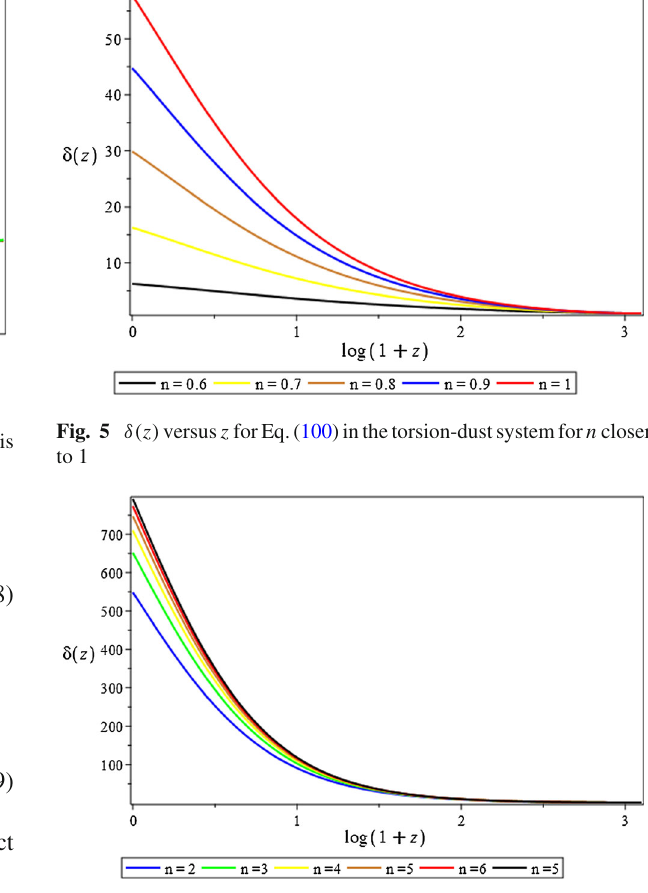
Fig. 6 δ( z ) versus z forEq.(100)inthedust-torsionsystemfor n > 1 .